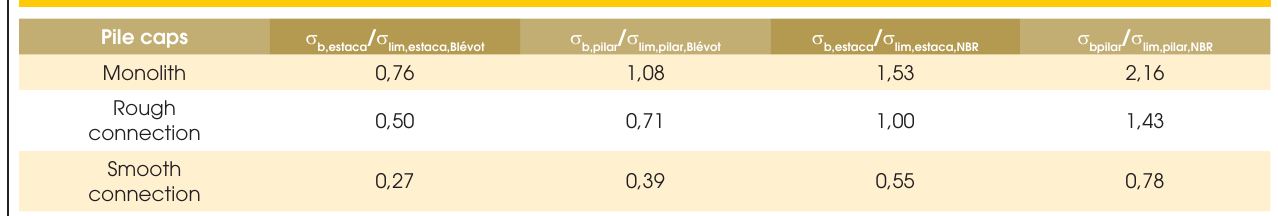
Table 3 – Ratio betweem in the nodal zone